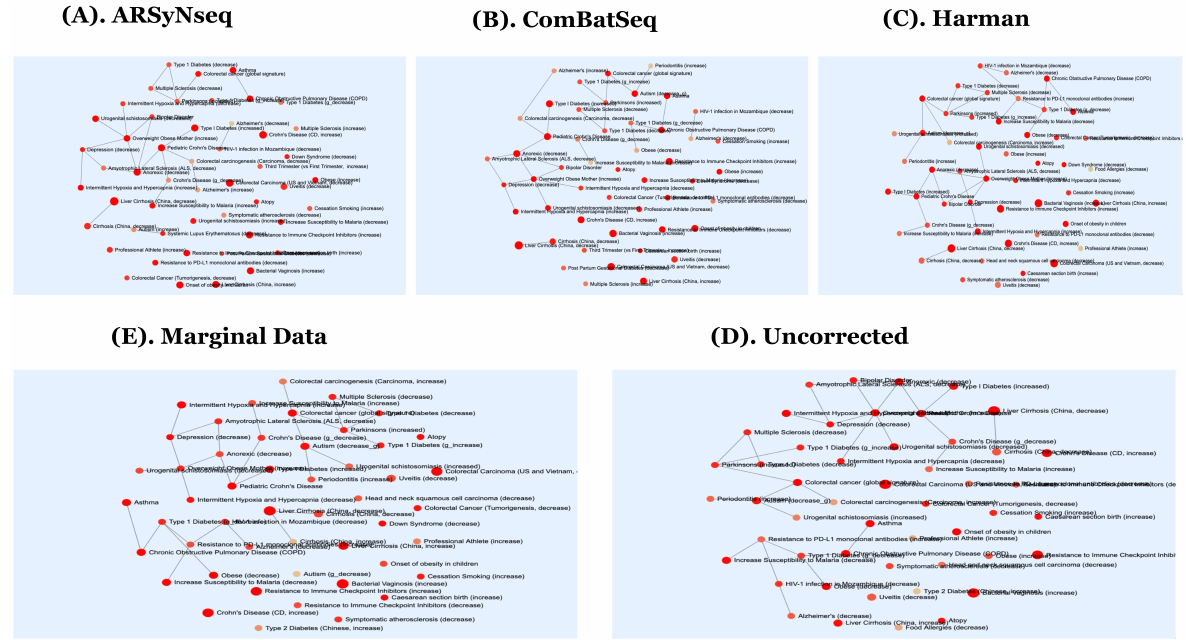
Figure 7. ( A – E ) show the network modules generated from MicrobiomeAnalyst [27,28] in TSEA (taxon set enrichment analyses) defined by host intrinsic taxon sets (ARSyNseq, ComBatSeq, Harman, Uncorrected, and Marginal Data) in clockwise from top-left